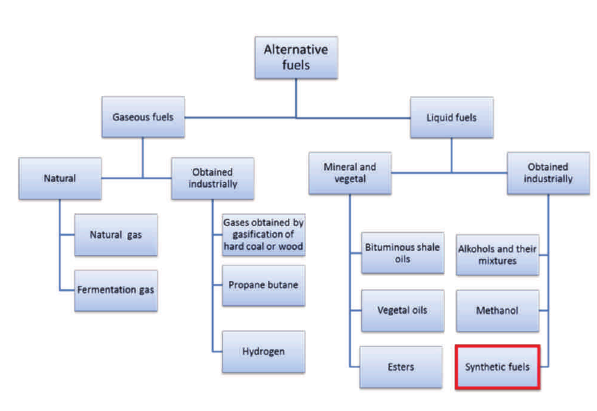
Fig. 1. Division of alternative fuels